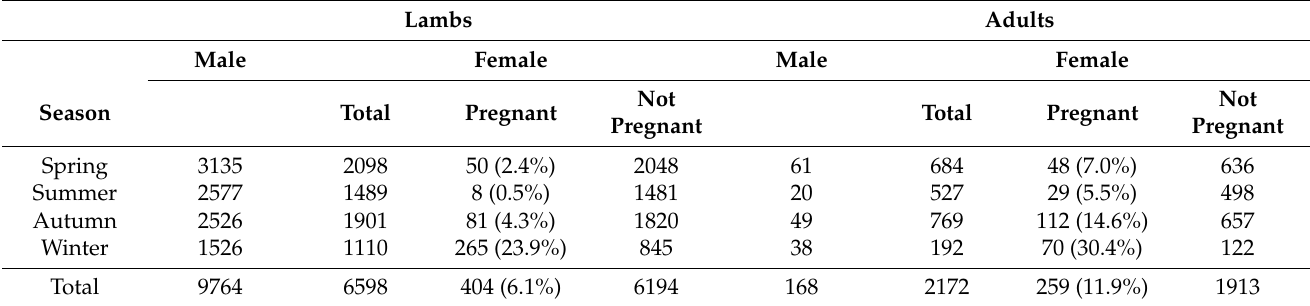
Table 1. Number of slaughtered sheep and lambs, divided by season, age class, gender, and pregnancy status. Lambs Adults Male Female Male